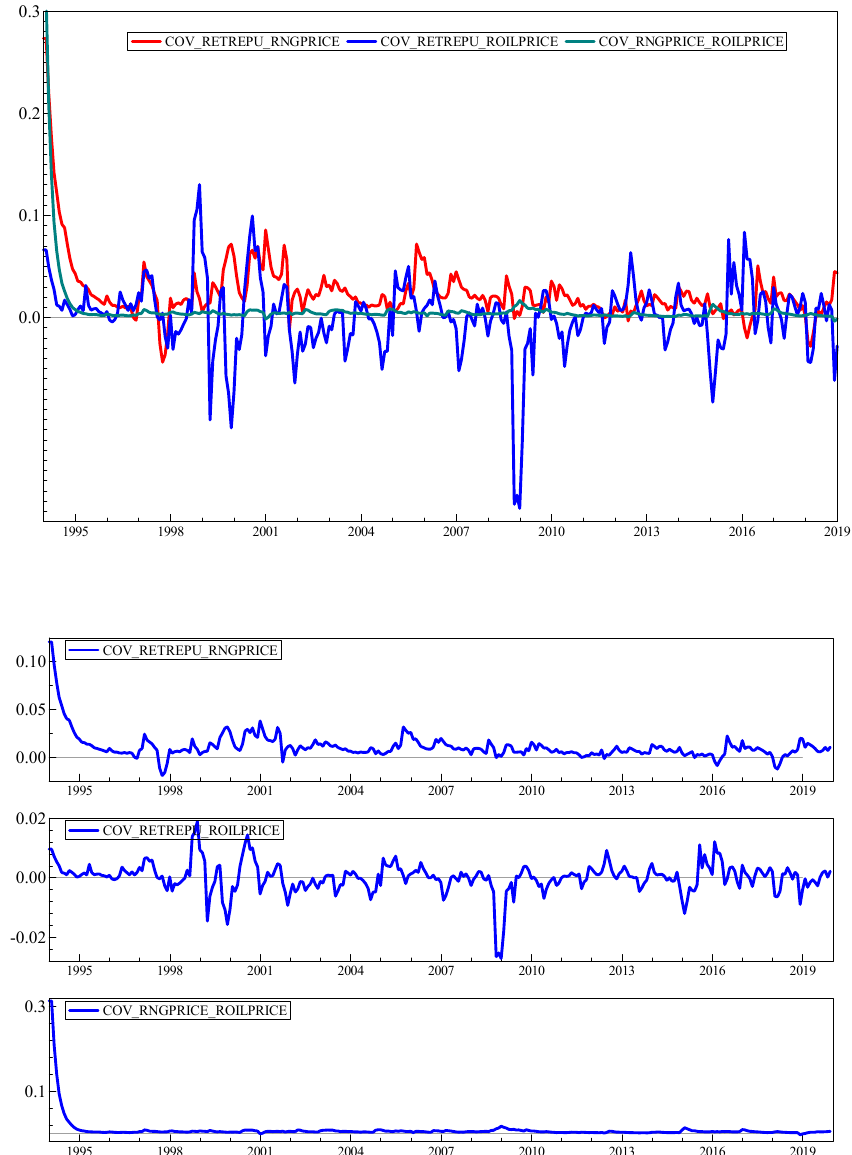
Figure 3. Conditional covariance of Russian economic policy uncertainty and energy prices.